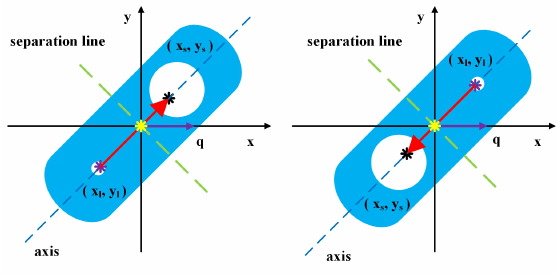
Figure 4. Result of the LIRS method.